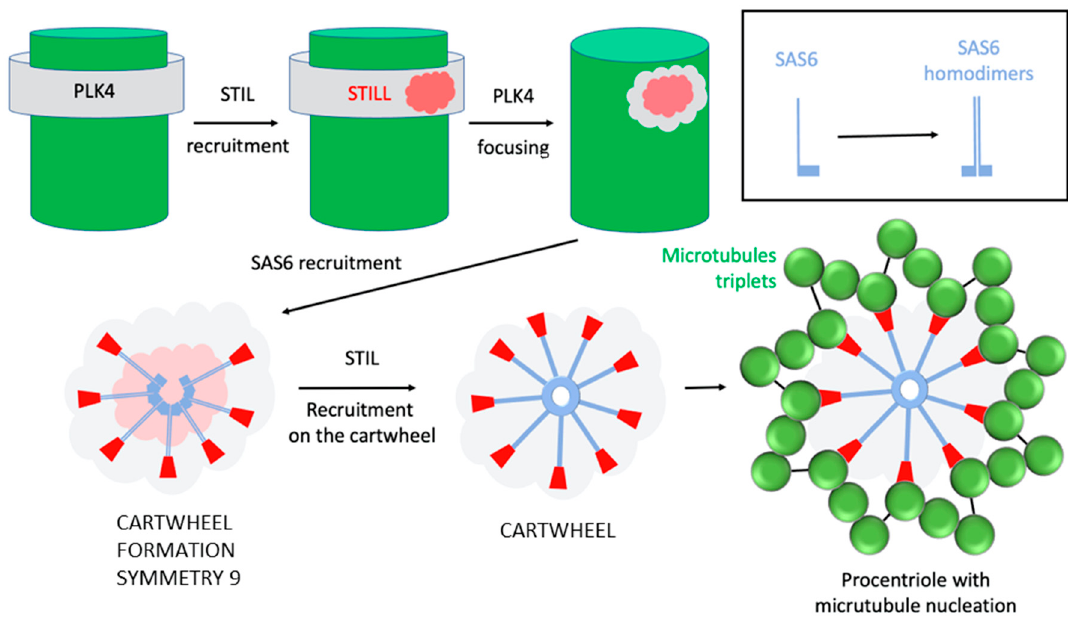
Figure 5. Cartwheel assembly: PLK4 ( grey ), located as a ring around the centriole, relocates by focusing on the STIL protein ( pink ). The assembly of the cartwheel begins with 9 SAS6 doublets stabilized by STIL, at the extremity of the coiled-coil regions of each doublet. STIL will ensure the link with each triplet of microtubules of the